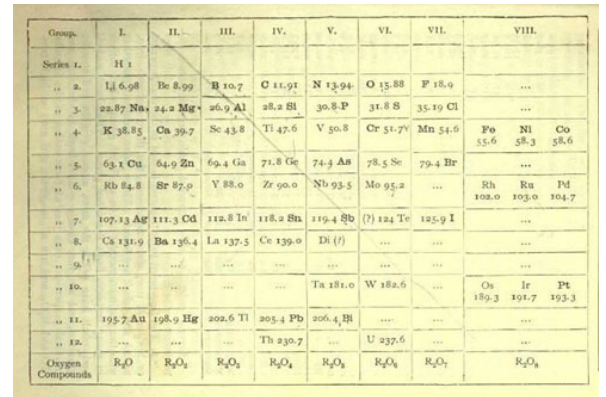
Figure 8. Textbook version of the periodic table –